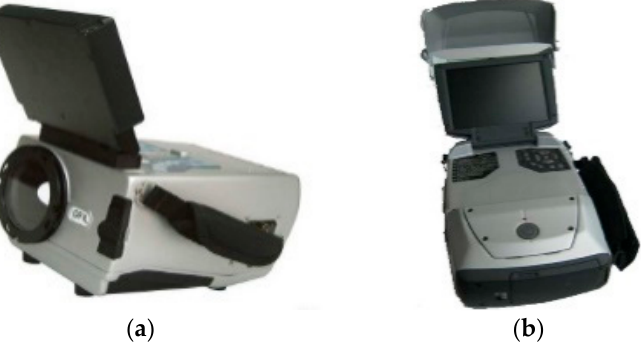
Figure 3. Ultraviolet (UV) imagers. ( a ) Type A; ( b ) Type B. Table 1. Basic parameters of the ultraviolet (UV) imagers.